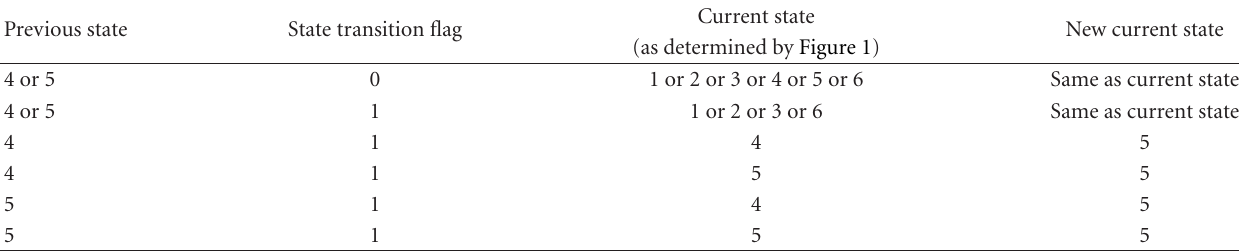
Table 5: Encoder state update chart.